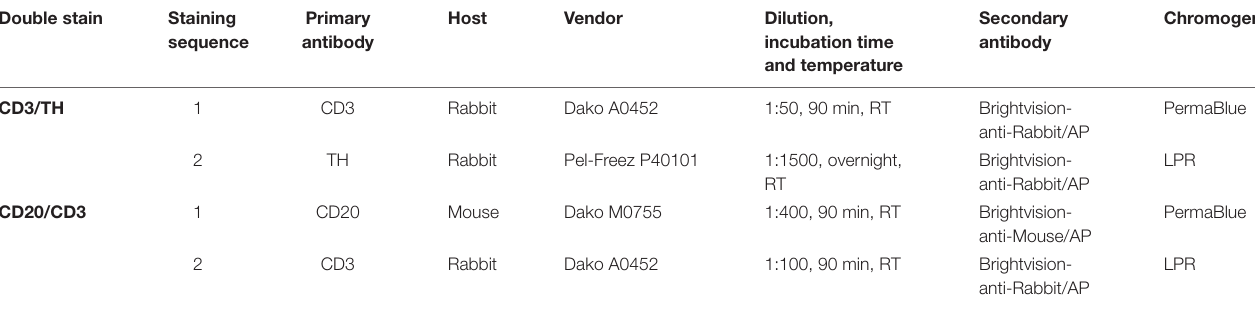
TABLE 2 | Detailed information on antibodies used in sequential double staining